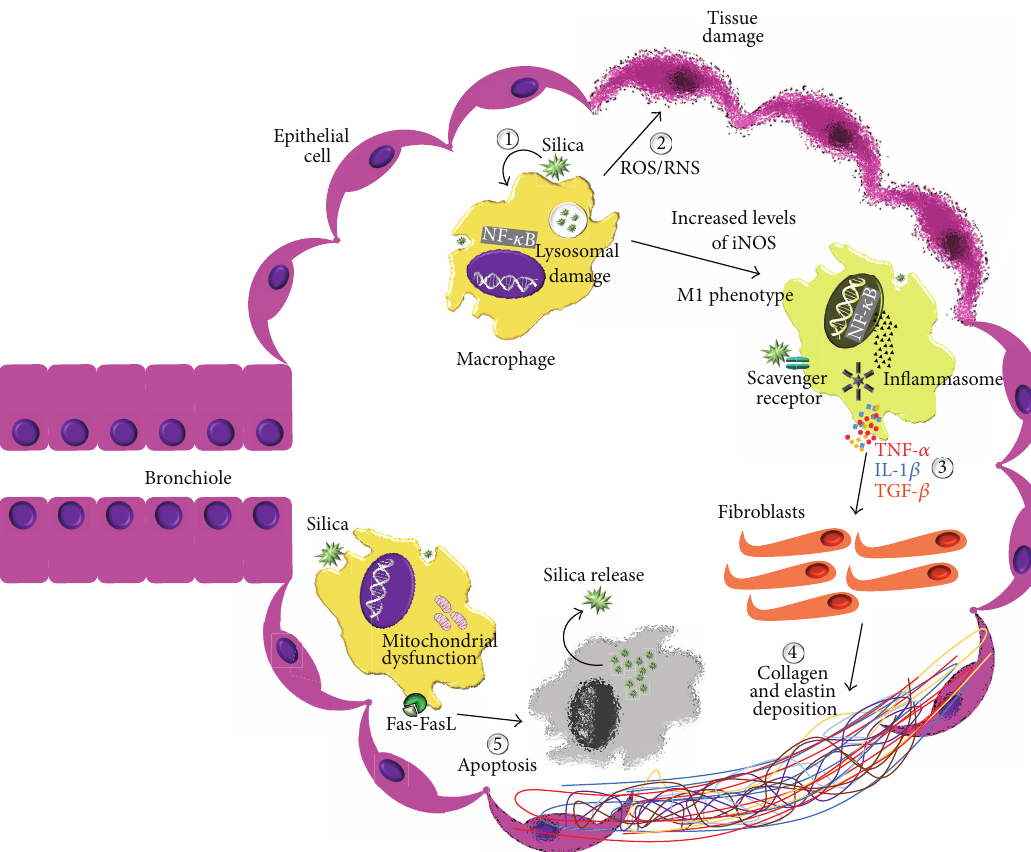
Figure 1: Silicosis pathogenesis. The main mechanisms that orchestrate the disease progression caused by silica-induced lung damage are (1) direct cytotoxicity, (2) production of reactive oxygen species (ROS) and reactive nitrogen species (RNS), (3) secretion of inflammatory and fibrotic mediators, (4) lung remodeling through collagen and elastin deposition, and (5) cell death by